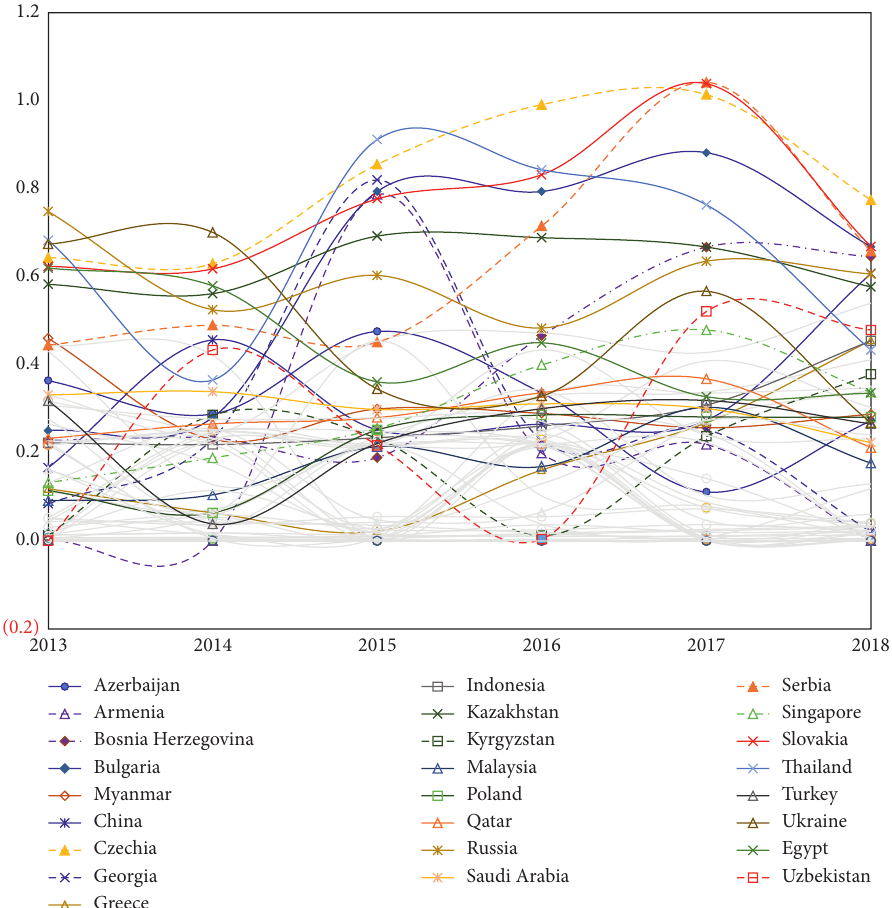
Figure 7: Evolution of the ranking of various countries by total